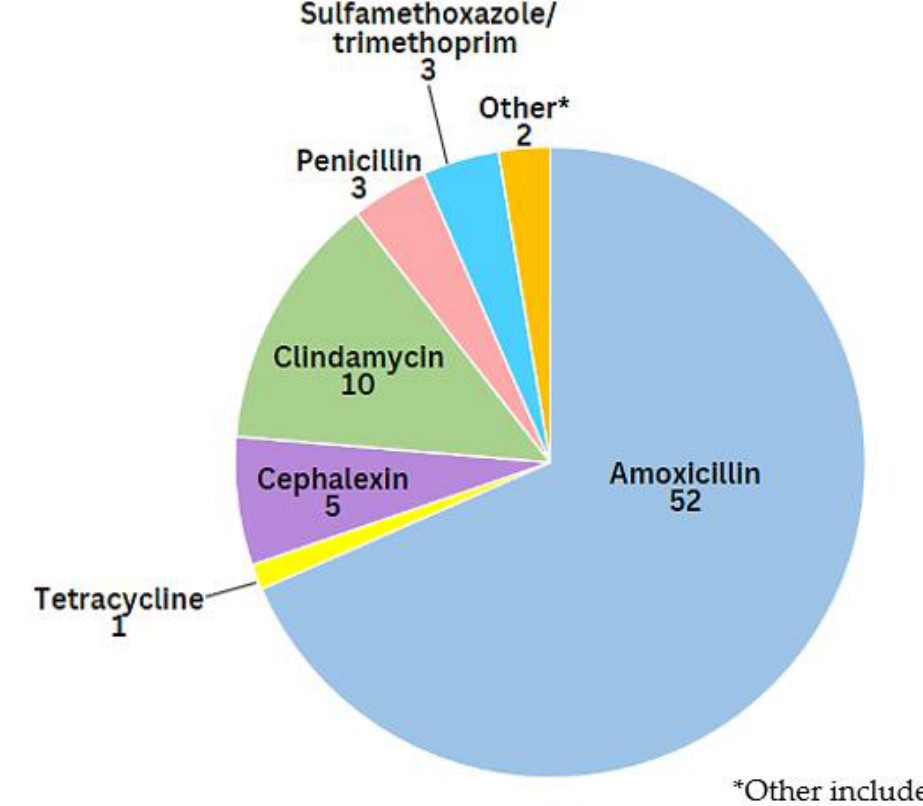
Figure 3. Types and number ( n ) of reported antimicrobials stored at home.